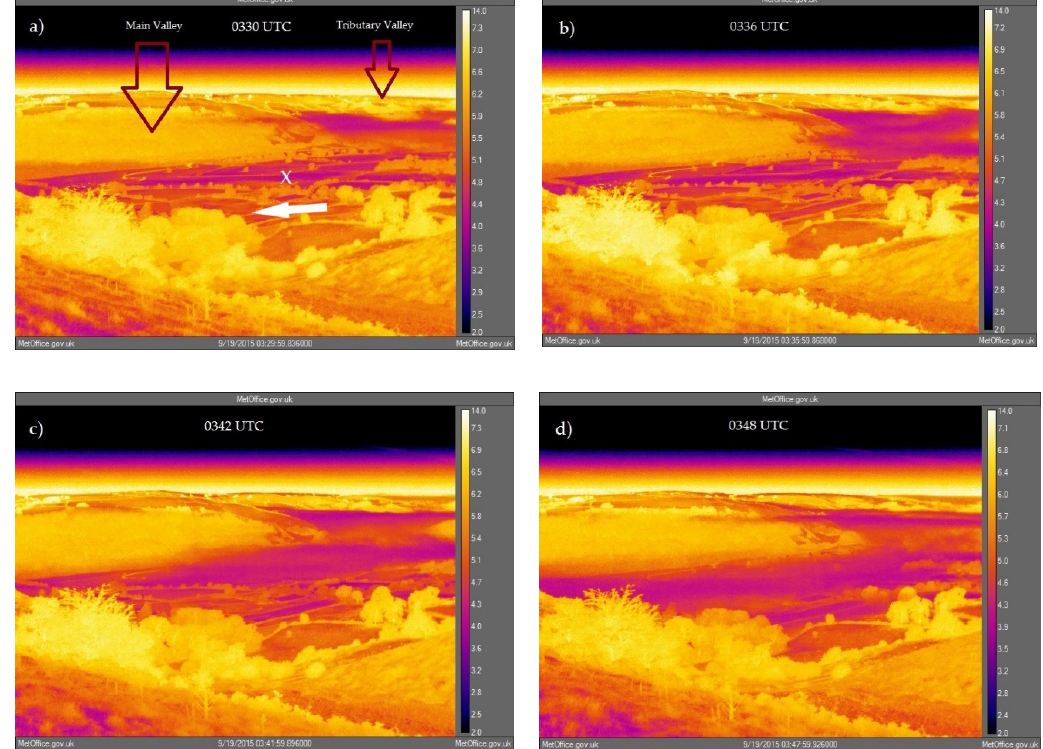
Figure 2. IR images taken during the LANFEX, 18–19 September 2015, at Skyborry for, ( a ) 0330 UTC, ( b ) 0336 UTC, ( c ) 0342 UTC and ( d ) 0348 UTC. The location of the meteorological measurement site is marked by an ‘X’, and the down-valley direction by an arrow in panel ( a ). The colour scale represents temperature (degrees C).